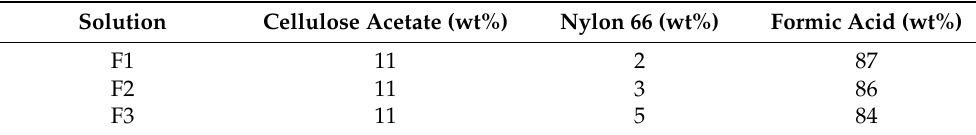
Table 2. Composition (wt%) of the developed membrane using Formic Acid as a